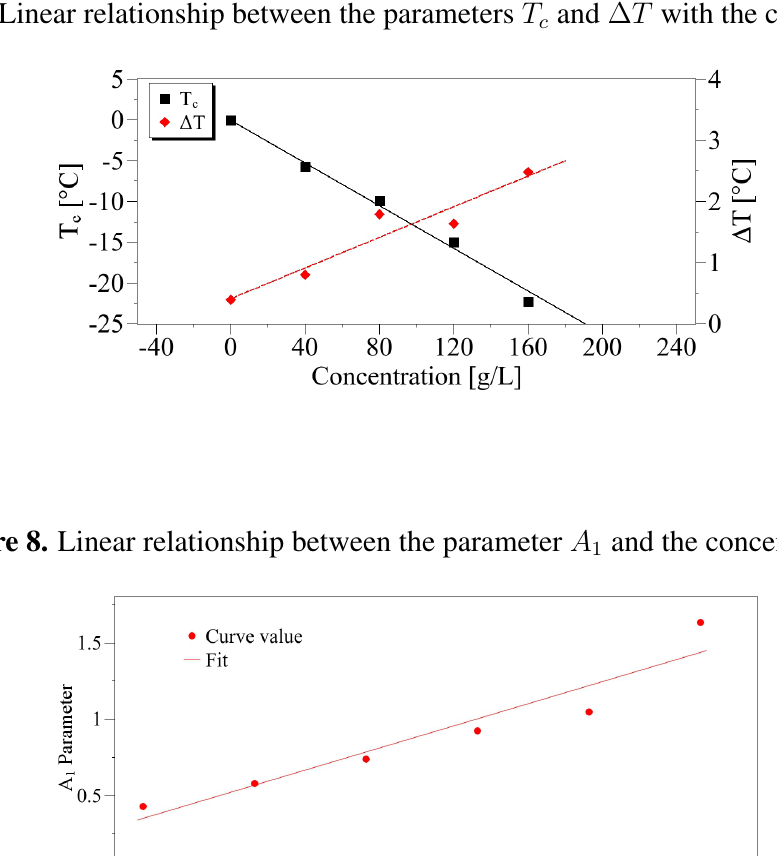
Figure 7. Linear relationship between the parameters T